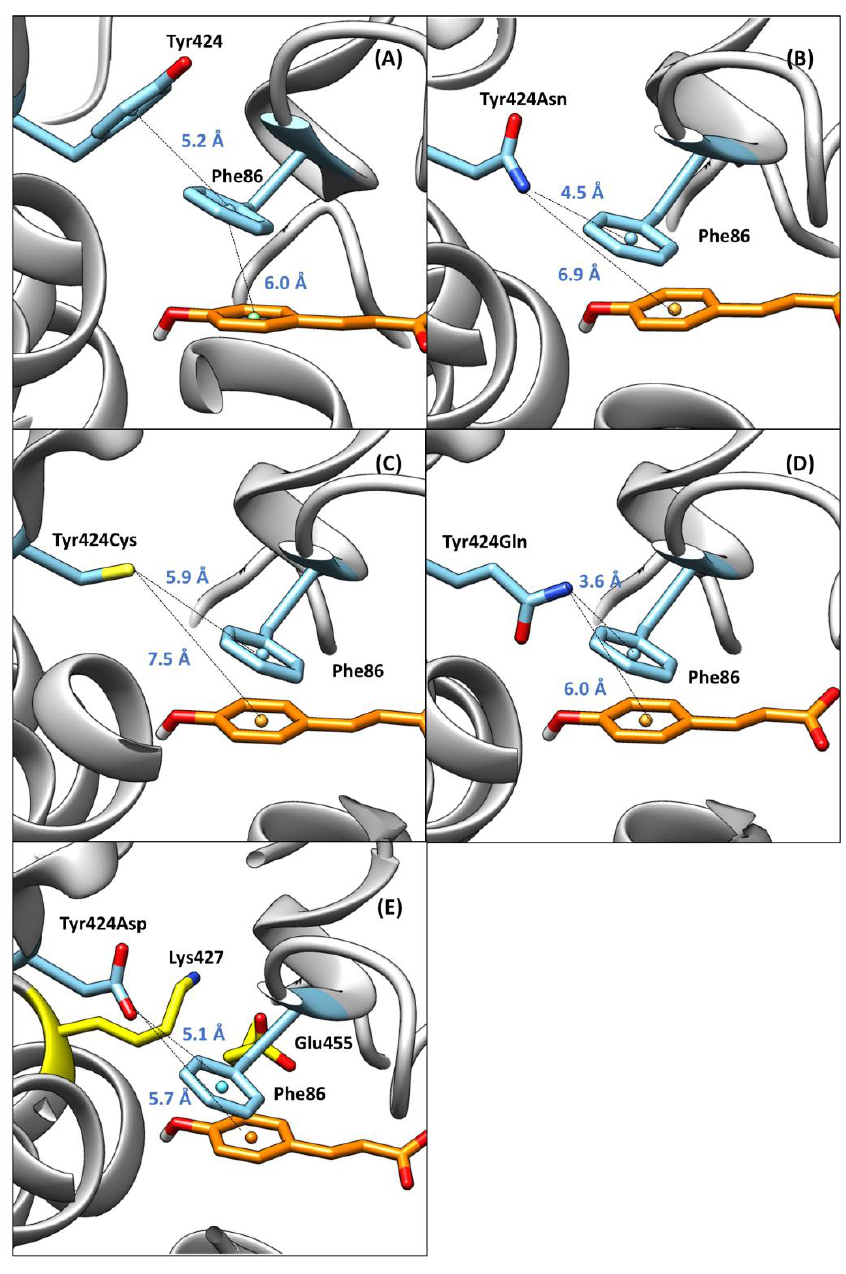
Figure 3. The docking structures with bound cinnamic acid as ligand in ( A ) the wild type, ( B ) the mutant Tyr424Asn, and ( C ) Tyr424Cys, ( D ) Tyr424Gln, and ( E ) Tyr424Asp. The residues are located above the aryl ring.